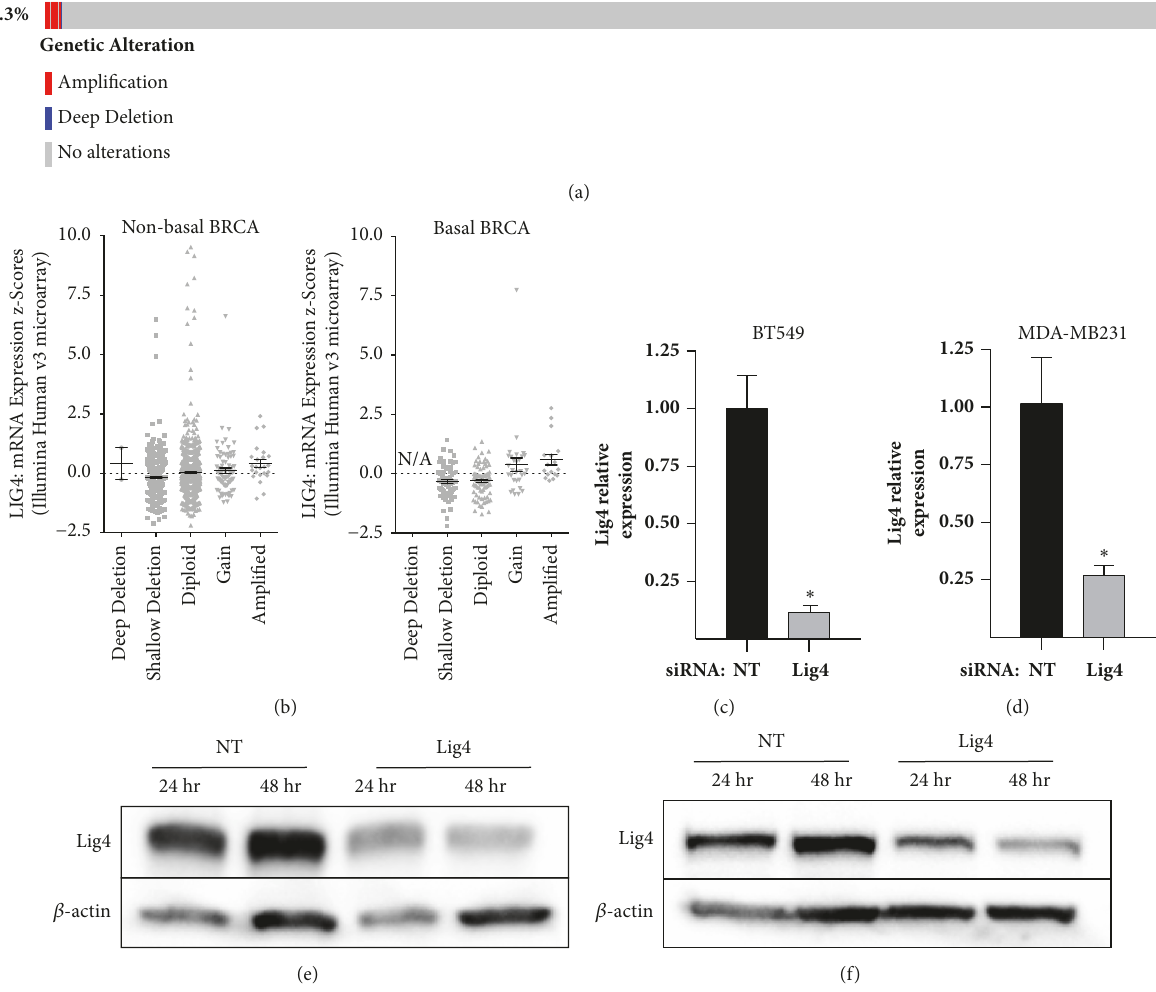
Figure 1: LIG4 a m pli fi cation in d i ff erent b reast cancer s ub t y pes. (a) Results were generated from cBioPortal analysis of the METABRIC breast cancer (BRCA) dataset (accessed April 2018). LIG4 amplification is observed in 8.1% of patients with basal breast cancer (n=209), significantly more frequently compared to alterations, including amplification and deep deletions, observed in 1.3% of cases in data from breast cancer subtypes excluding basal (n=2300 patients; p < 0.0001). (b) In all nonbasal BRCA patients genomic alterations in LIG4 were not associated with altered mRNA expression (n=2300, p=0.8348) whereas a positive association was detected in patients with basal BRCA (n=209, p < 0.0001). Cells were transfected with a single construct siRNA targeting either Lig4 or scrambled control (NT) for 24 hr or 48 hr. Lig4 depletion was confirmed using qPCR (c, d; ∗ p < 0.05; data plotted are mean + SEM) and western blot (e: BT549, f: